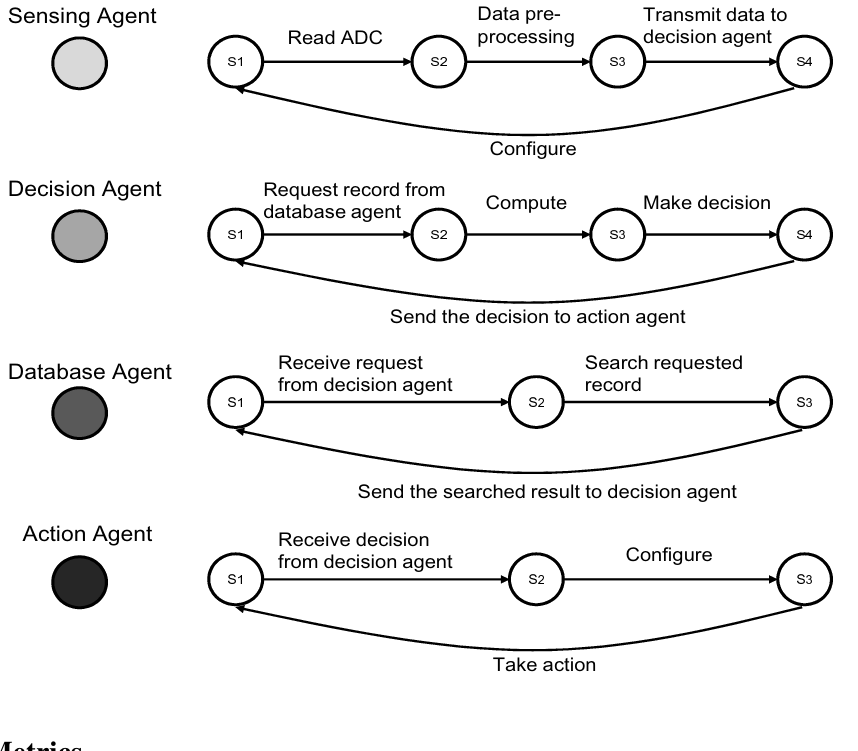
Figure 13. The finite state machines for each agent under the QoS oriented